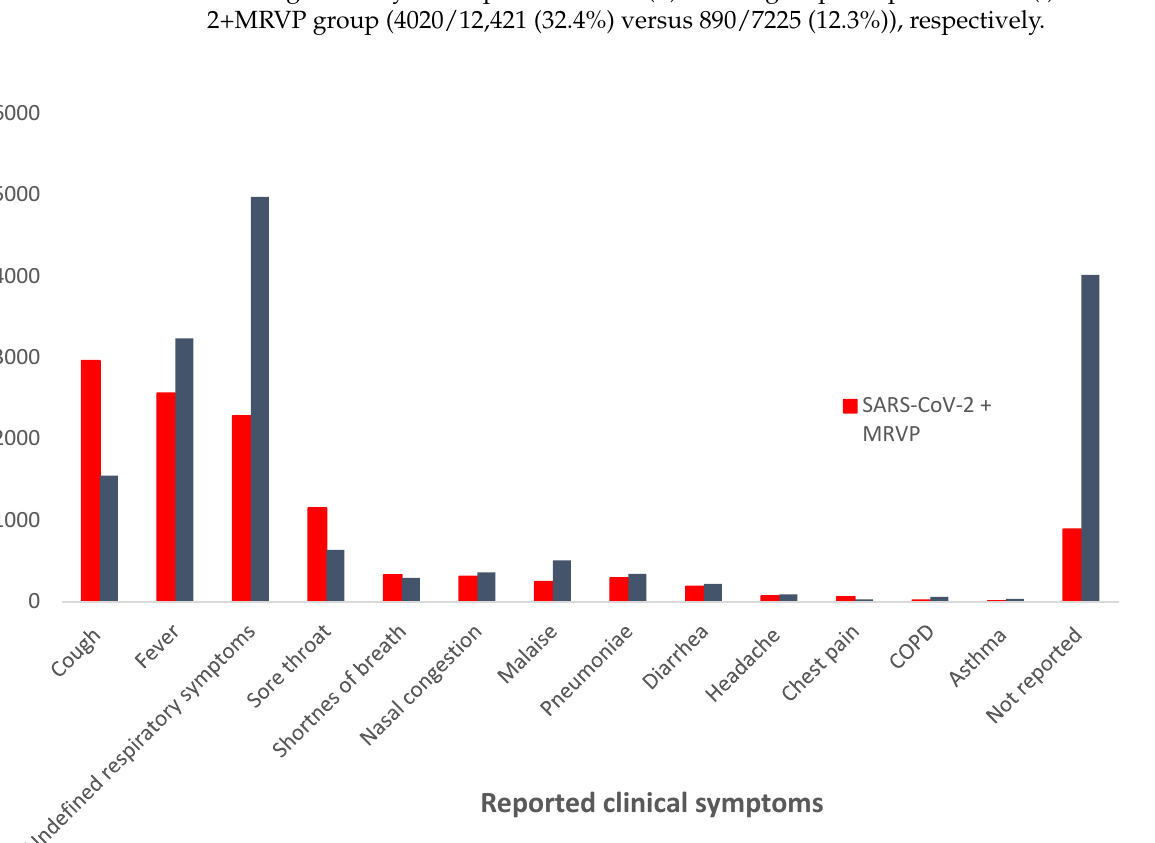
Figure 1. Comparison of reported symptoms among individuals tested by (i) SARS-CoV-2 + MRVP and (ii) MRVP. Counts in this figure represent the frequency of each symptom reported. More than one symptom was reported by many individuals; therefore the sum of symptoms frequency do not match with the total number of specimens tested. Undefined respiratory symptoms represent a general term recorded by clinicians on the requisition to indicate the presence of any respiratory symptoms without providing further specifics. Not all individuals had symptom information recorded in laboratory requisition. COPD—coronary obstructive pulmonary disease.